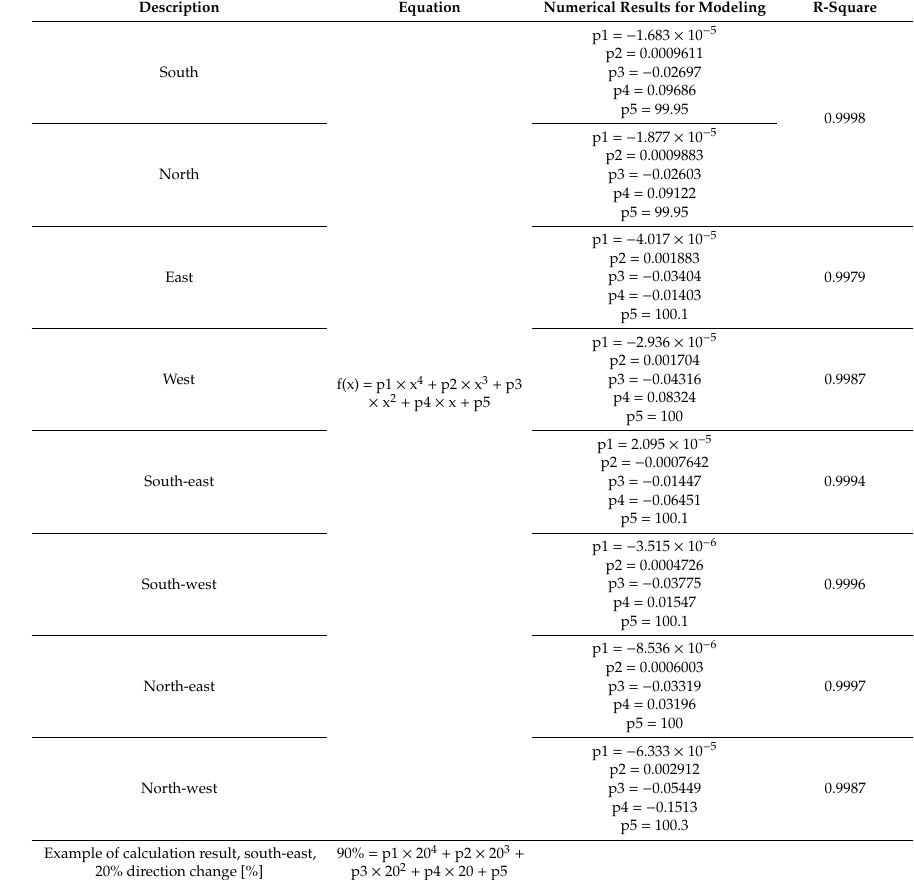
Table 6. The e ff ect of directional changes on m-Si performance (x = change in orientation ( ◦ ); f(x) = percentage value of the performance compared to the